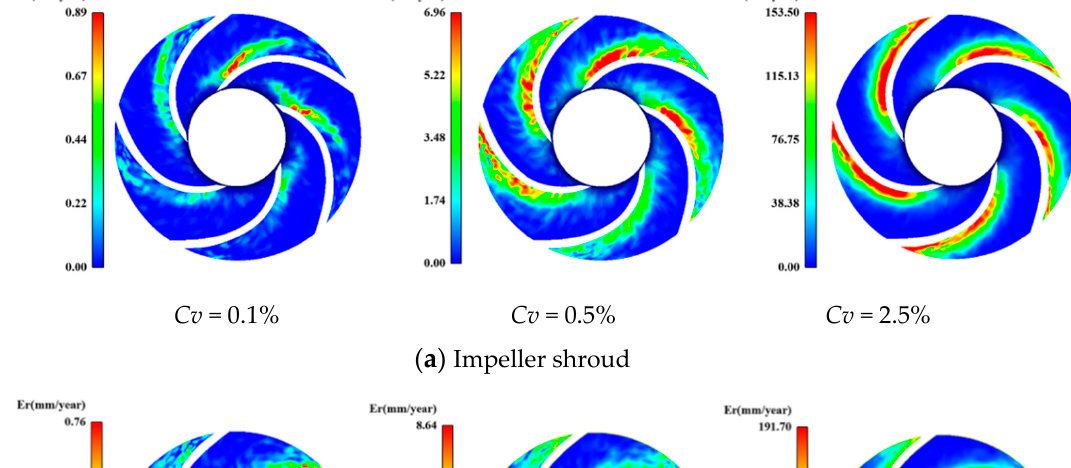
nent. The simulated flow rates are 0.6 Q d , 1.0 Q d, and 1.4 Q d , respectively. It is found from Figure 10a that the maximum erosion occurs on the pressure side of the blades at the low (0.6 Q d ) and nominal (1.0 Q d ) flow rates under 0.1% particle volume fraction. The maximum annual erosion rate is 1.12 mm/year and 1.97 mm/year, respectively. At the large (1.4 Q d ) flow rate, the maximum erosion occurs on the internal surface of the volute with an annual erosion rate of 3.45 mm/year. The increasing rate of erosion is largest on the volute surface with the increasing flow rate, as seen in Figure 10a. When the particle volume fraction increases to 0.5%, the maximum erosion occurs on the blades at all simulated flow rates. At the low and nominal flow rates, the maximum erosion rates on the shroud and hub of the impeller and the volute are comparable, while at the large flow rate, the erosion on the volute is significantly increased to the level comparable to that on the blades. When the particle volume fraction increases to 2.5%, the maximum erosion occurs on the blades at all simulated flow rates, and the annual erosion rate exceeds over 100 mm/year, which indicates that the hydraulic part of the pump cannot work normally in such harsh condi- tions. The general features of the erosion on the pump components can be concluded as follows. The maximum erosion always occurs on the pressure side of the blades at all simulated scenarios except for the case of 0.1% and 1.4 Q d , in which the erosion on the volute is larger. The rate of increase in the erosion rate is largest on the internal surface of the volute with respect to the flow rate. The erosion rates on the shroud and hub of the impeller are comparable at all simulated conditions. The erosions that occurred in the ex- tended pipes of the inlet and outlet are much smaller than the other components. ( a ) Maximum erosion at the different flow rates under 0.1% particle volume fraction ( b ) Maximum erosion at the different flow rates under 0.5% particle volume fraction